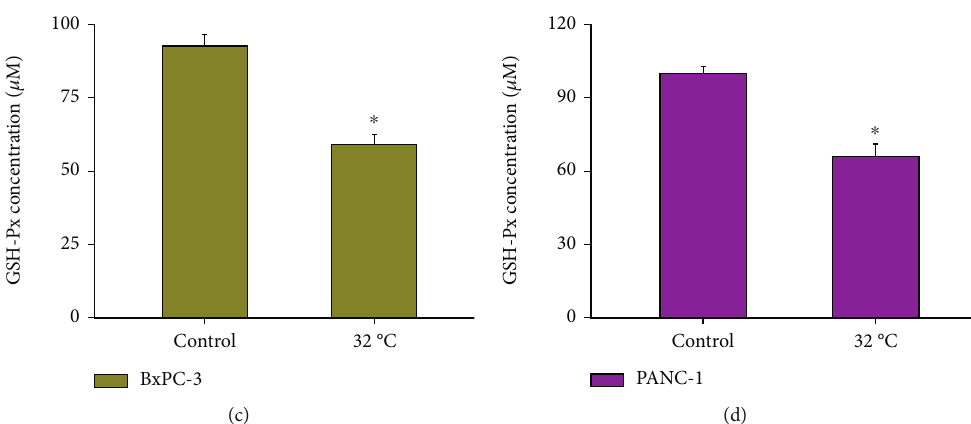
Figure 3: Cold induces Fe 2+ accumulation and abnormal oxidative stress. BxPC-3 and PANC-1 cells were cultured at 37 (Control) or 32 ° C. (a) The increase in Prussian blue staining indicated an increase in Fe 2+ accumulation level. (b) Representative confocal fl uorescent images of MitoTracker ™ Red FM (the mitochondrial indicator) and DCFH-DA (ROS indicator)-loaded cells. (c) GSH-Px activity was measured using a GSH-Px assay kit. ∗ P < 0 : 05 versus